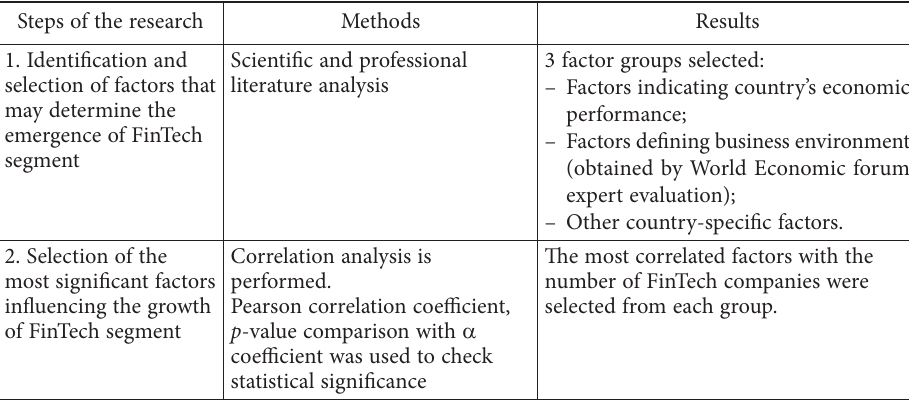
Table 1. The research framework (source: authors) Steps of the research Methods Results